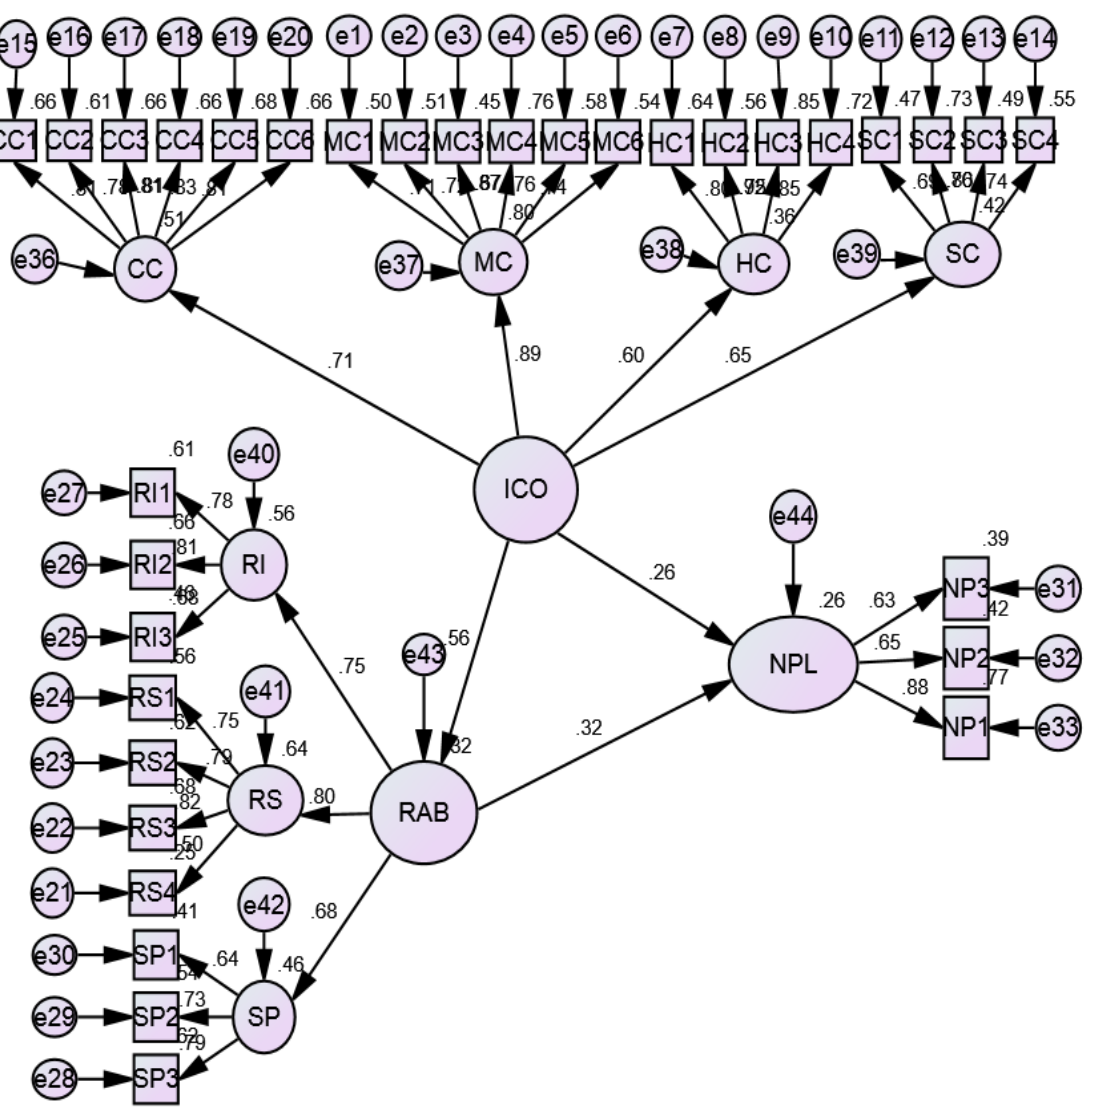
Figure 2. Mediating structural model.